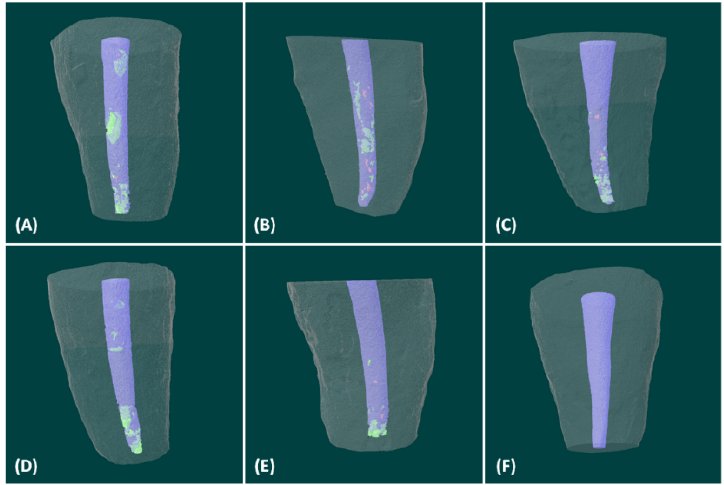
Figure 3. Representative 3-dimensional reconstructions of micro-CT scans illustrating the presence of distribution of voids within the root canal fillings. Red indicates closed porosity, green indicates open porosity, and purple indicates MTA fillings. ( A ) EZ-seal + Hand condensation ( B ) EZ-seal + Compactor activation ( C ) EZ-seal + Reverse rotary motion ( D ) OrthoMTA + Hand condensation ( E ) OrthoMTA + Compactor activation ( F ) OrthoMTA + Reverse rotary motion.